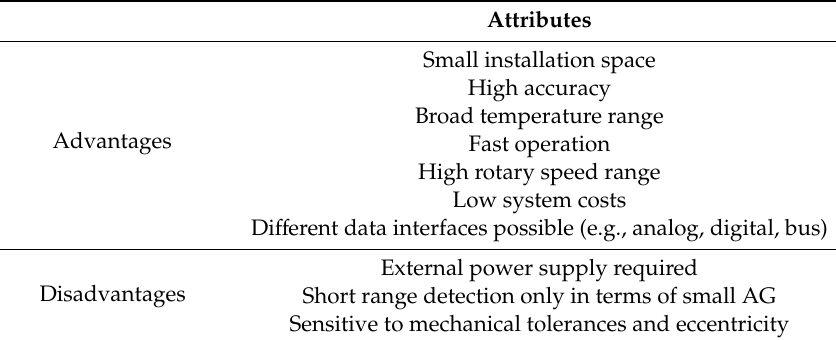
Figure 12. Typical setup of an AMR / GMR sensor. Table 4 concludes both the strengths and weaknesses of the AMR / GMR position sensor technology. Table 4. Listing of the strengths and weaknesses of magnetoresistive